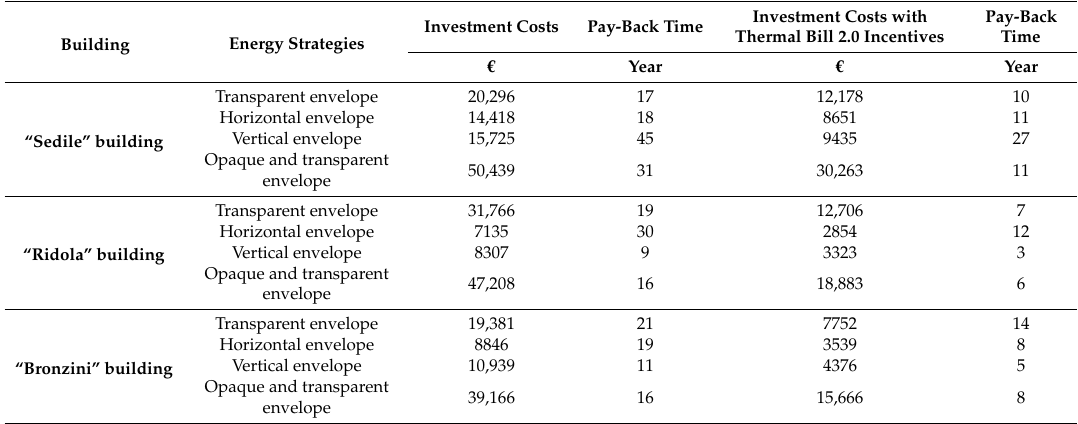
Table 14. Economic feasibility study on envelope.